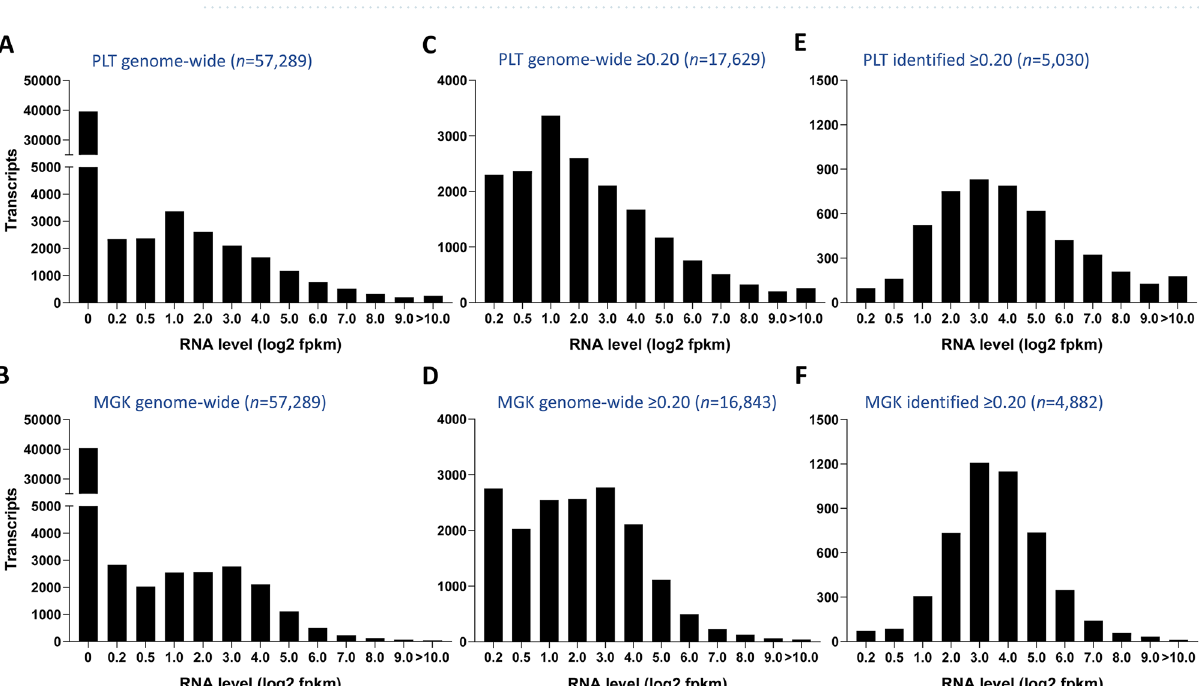
Figure 3. Histograms of RNA levels in transcriptome of platelets (PLT) or megakaryocytes (MGK). ( A , B ) Distribution of all 57,289 genome-wide transcripts. ( C , D ) Distribution of all relevant transcripts (log2fpkm ≥ 0.20) for PLT ( n = 17,629) or MGK ( n = 16,843). ( E , F ) Distribution of protein-coding transcripts, as identified in the proteome, for PLT ( n = 5,030) or MGK ( n = 4,882). Levels of RNA expression (log2fpkm) were binned as < 0.20, 0.20–0.50, 0.50–1.00, 1.00–2.00, etc. For flow of numbers of transcripts and proteins, see Fig.